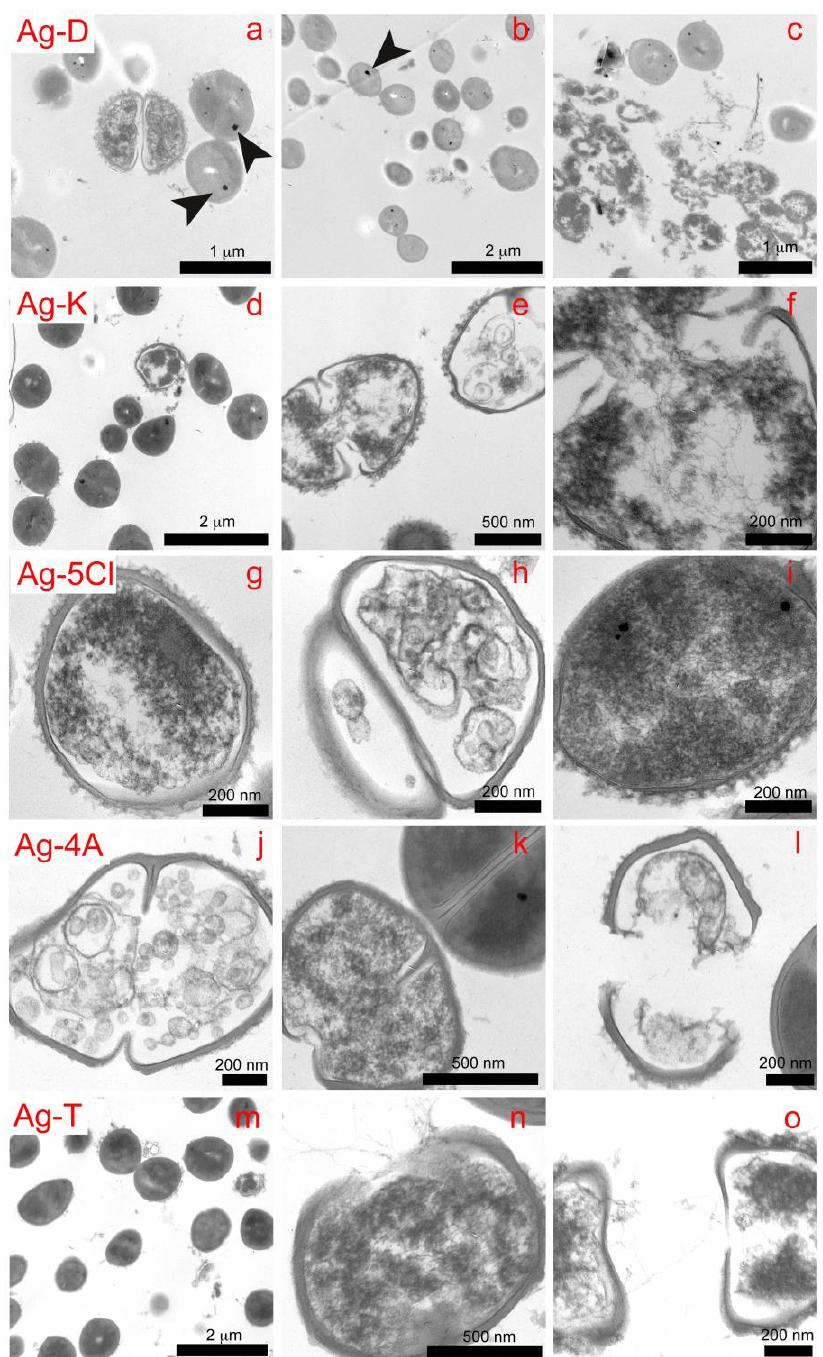
Figure 6. Cross sections showing the effects on S. epidermidis of all the compounds (Ag-D, Ag-T, Ag-5Cl, Ag-4A, and Ag-T) after 45 min of exposure.